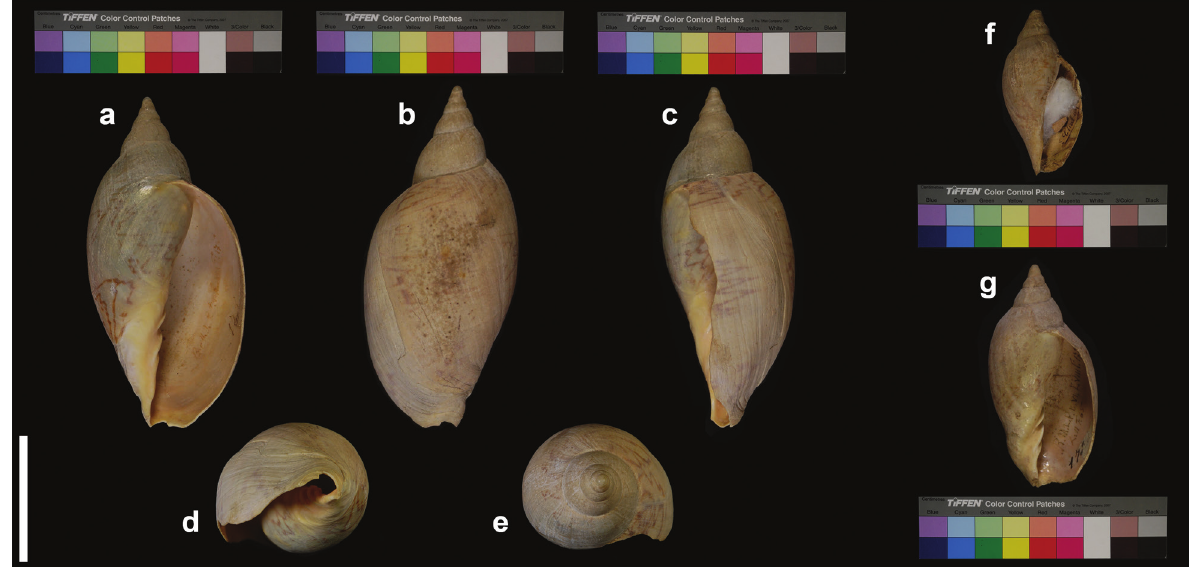
Figure 41. Voluta magellanica typica . a–e: Specimen figured by Lahille (1895: pl. VIII, fig. 175) a Apertural view b Dorsal view c Lateral view d Umbilical view e Apical view f–g Apertural view of two other specimens figured by Lahille (1895), see references on Table 16. Scale bar: 5